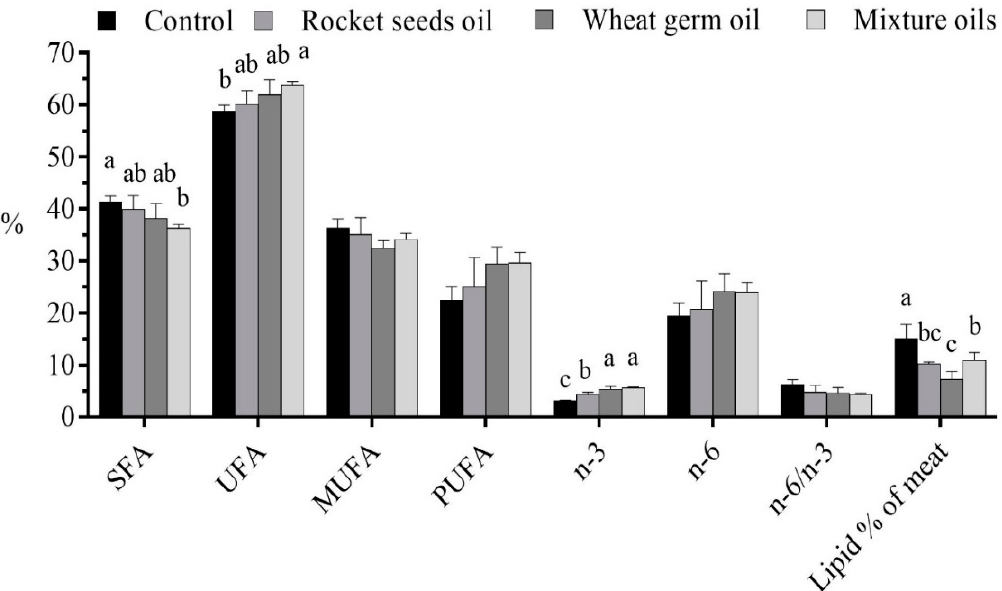
Figure 3. Meat fatty acid profile and lipids content of V-line growing rabbits (5–12 weeks of age) that were administered orally with rocket seed oil, wheat germ oil, and their mixture. Columns marked with different superscripts are significantly different at p ≤ 0.05. SFA: Saturated fatty acids; UFA: Unsaturated fatty acids; MUFA: Monounsaturated fatty acids; PUFA: Polyunsaturated fatty acids; n-3: Omega-3; n-6: Omega-6.